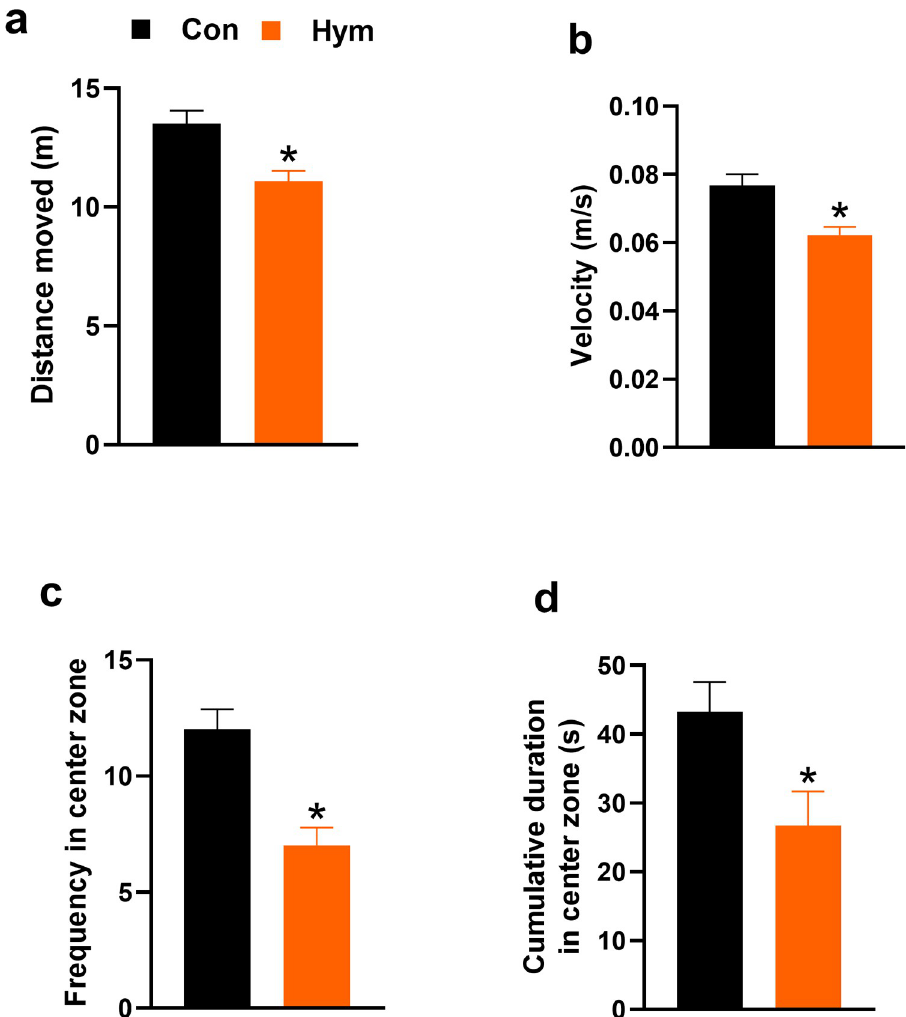
Fig 1. Main Open Field parameters for the control rats (Con, n = 8) and rats infected with H . diminuta (Hym, n = 7). Infected animals exhibited reduced distance moved (a), velocity (b), frequency in the center zone (c) as well as reduced time spend in the central zone of the apparatus (d). � Hym vs Con, p < 0.05 (Newman-Keuls test). ��� Hym vs Con, p < 0.005 (Newman-Keuls test).